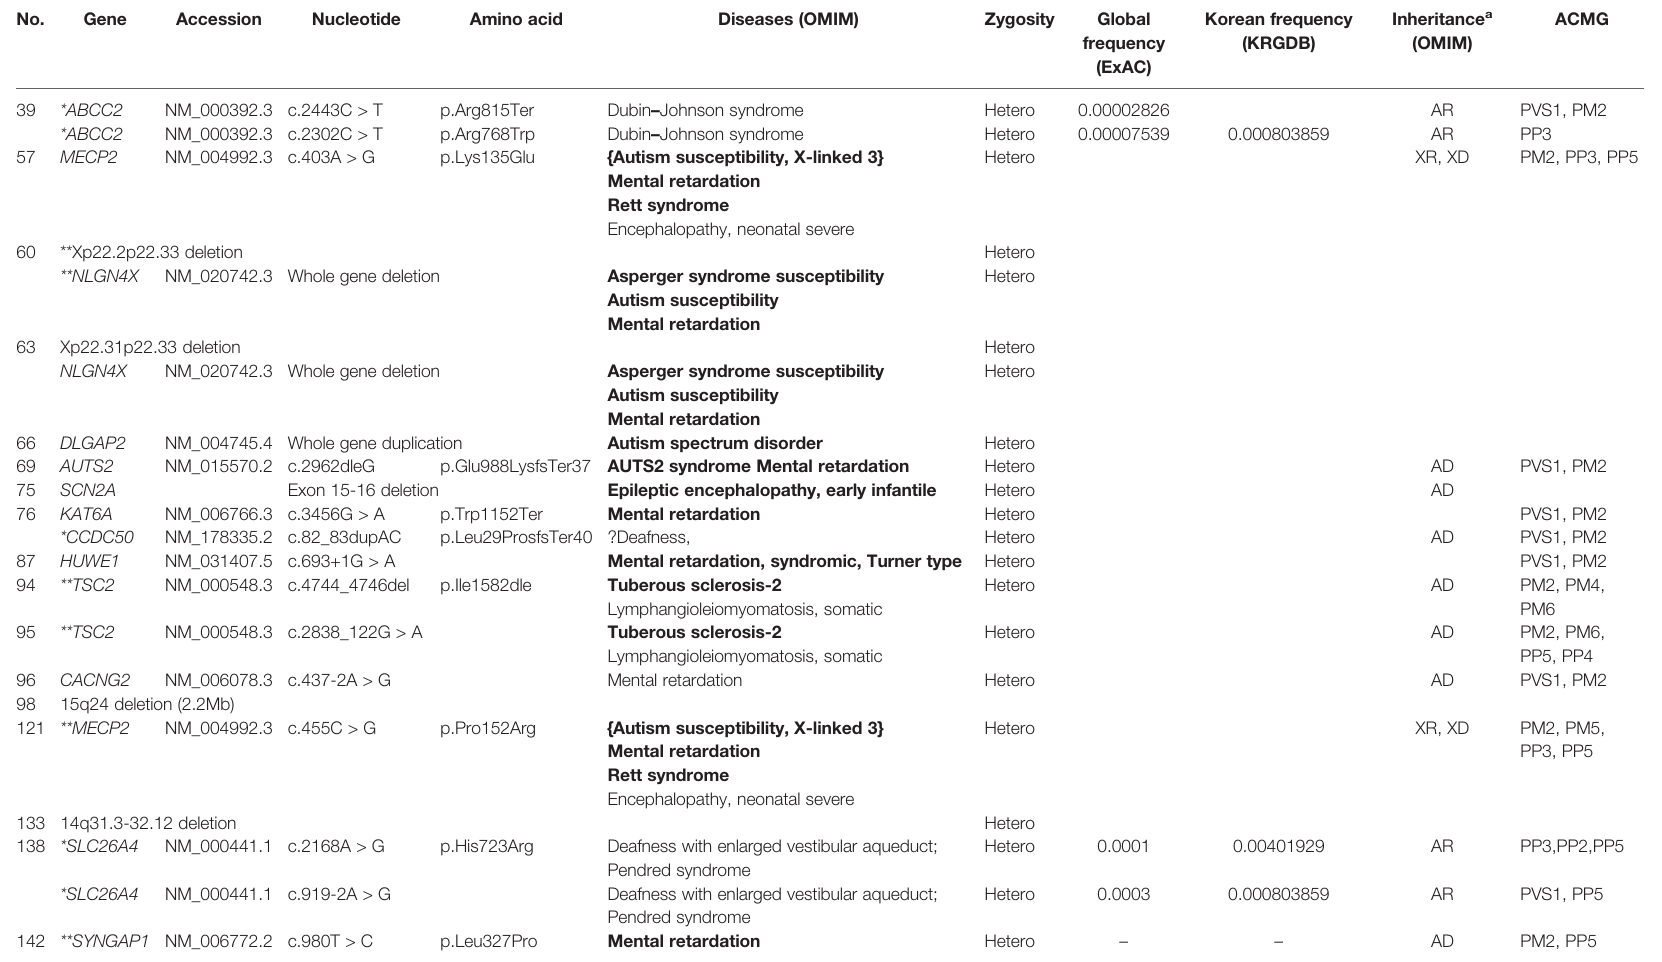
TABLE 4 | Genetic characteristics: genes with likely pathogenic